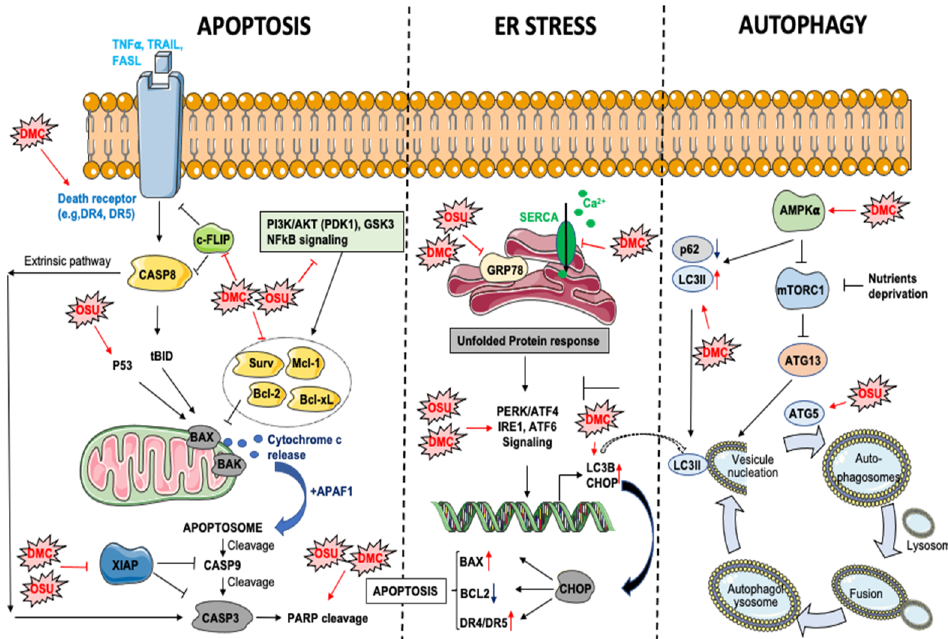
Figure 2. Impact of OSU-03012 (OSU) and DMC on apoptosis, ER stress and autophagy processes. AMPK: AMP-activated protein kinase. APAF1: Apoptotic peptidase activating factor 1. ATF6: Activating transcription factor 6. ATG: autophagy-related protein. BAK: Bcl-2 homologous antagonist killer. BAX: Bcl-2–associated X protein. Bcl-2: B cell lymphoma 2. Bcl-xL: B cell lymphoma extra-large. CASP: caspase. c-FLIP: cellular FLICE (FADD-like IL-1 β -converting enzyme)-inhibitory protein. CHOP: C/EBP Homologous Protein. DMC: 2,5-dimethyl celecoxib. DR5: death receptor 5. ER: endoplasmic reticulum. FasL: Fas Ligand. GRP78: glucose-regulated protein 78. IRE1: Inositol-Requiring Enzyme 1. LC3: Microtubule Associated Protein 1 Light Chain 3. Mcl-1: myeloid cell leuke- mia 1. mTORC1: mammalian target of rapamycin complex 1. NFkB: nuclear factor kappa B. OSU: